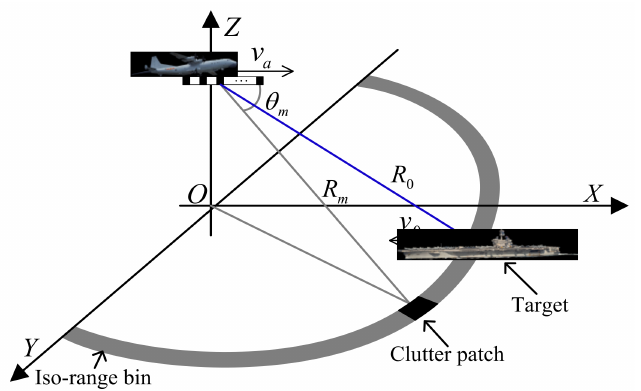
Figure 1. Geometric sketch of airborne